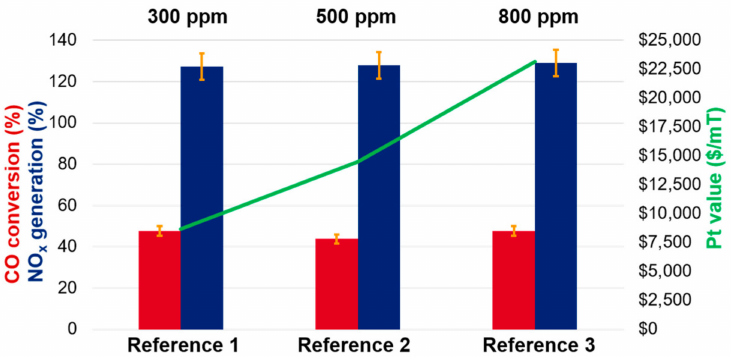
Figure 2. The CO conversion and NO x generation observed for reference catalysts with varying Pt loadings are reported. The respective value of Pt ($/mT) at a 2016–2020 average market price of 900 $/oz t Pt [11] is also reported for